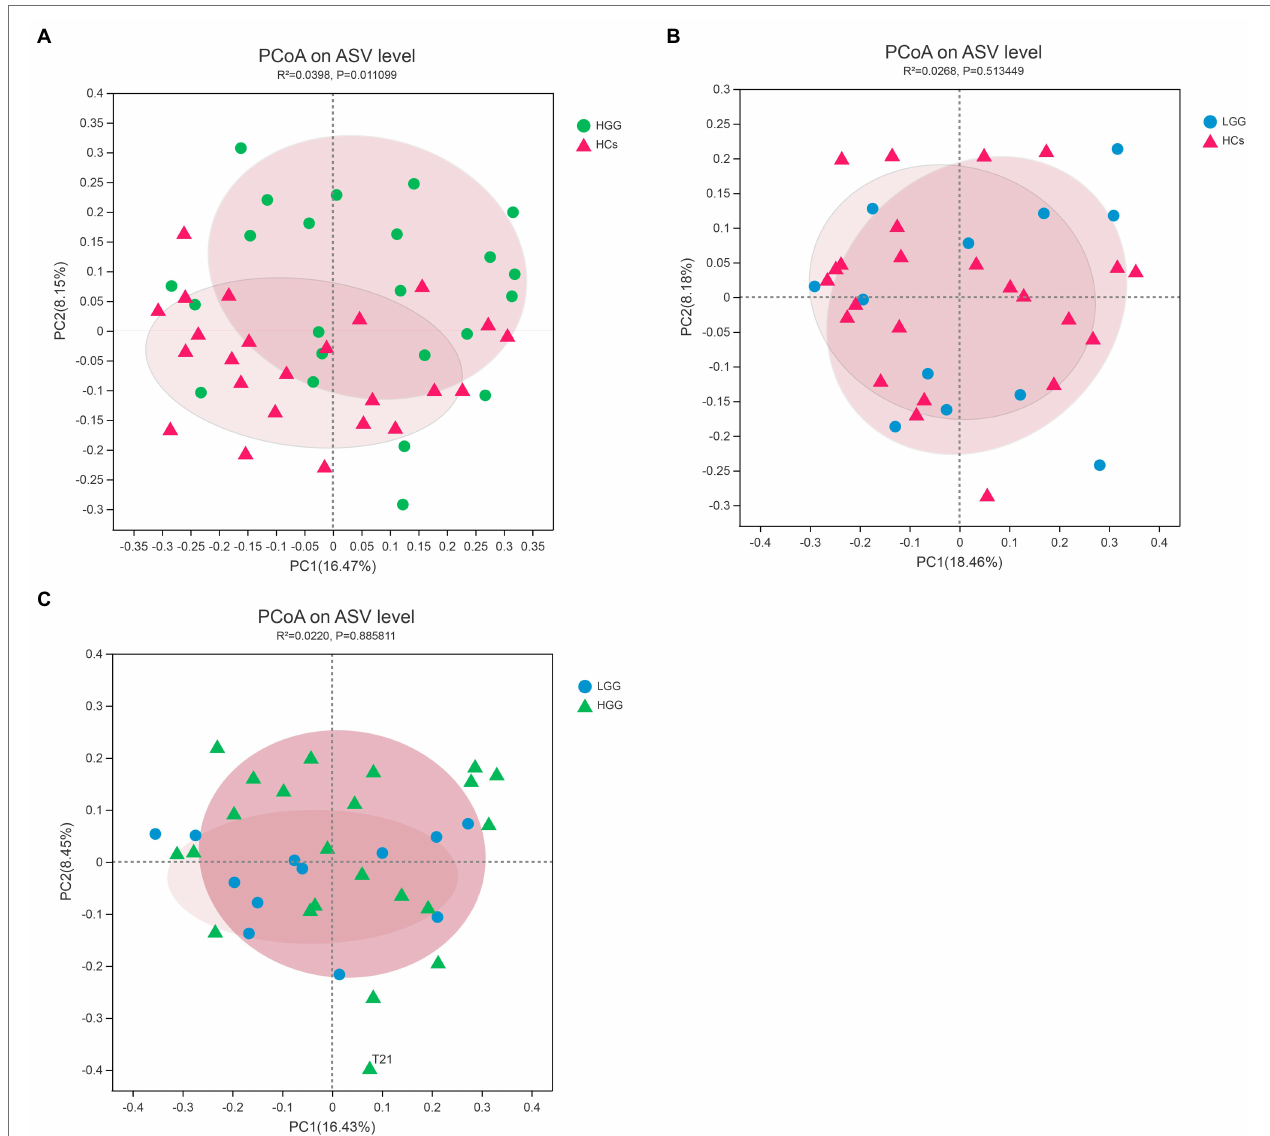
FIGURE 1 | Principal component analysis (PCoA) plots based on the Bray-Curtis distances showed distinct clusters in (A) HCs&HGG, (B) HCs&LGG, and (C) HGG&LGG. The individual samples are color-coded to indicate HCs (red), LGG (blue), and HGG (green). HCs, healthy controls; HGG, high-grade glioma; LGG, low-grade